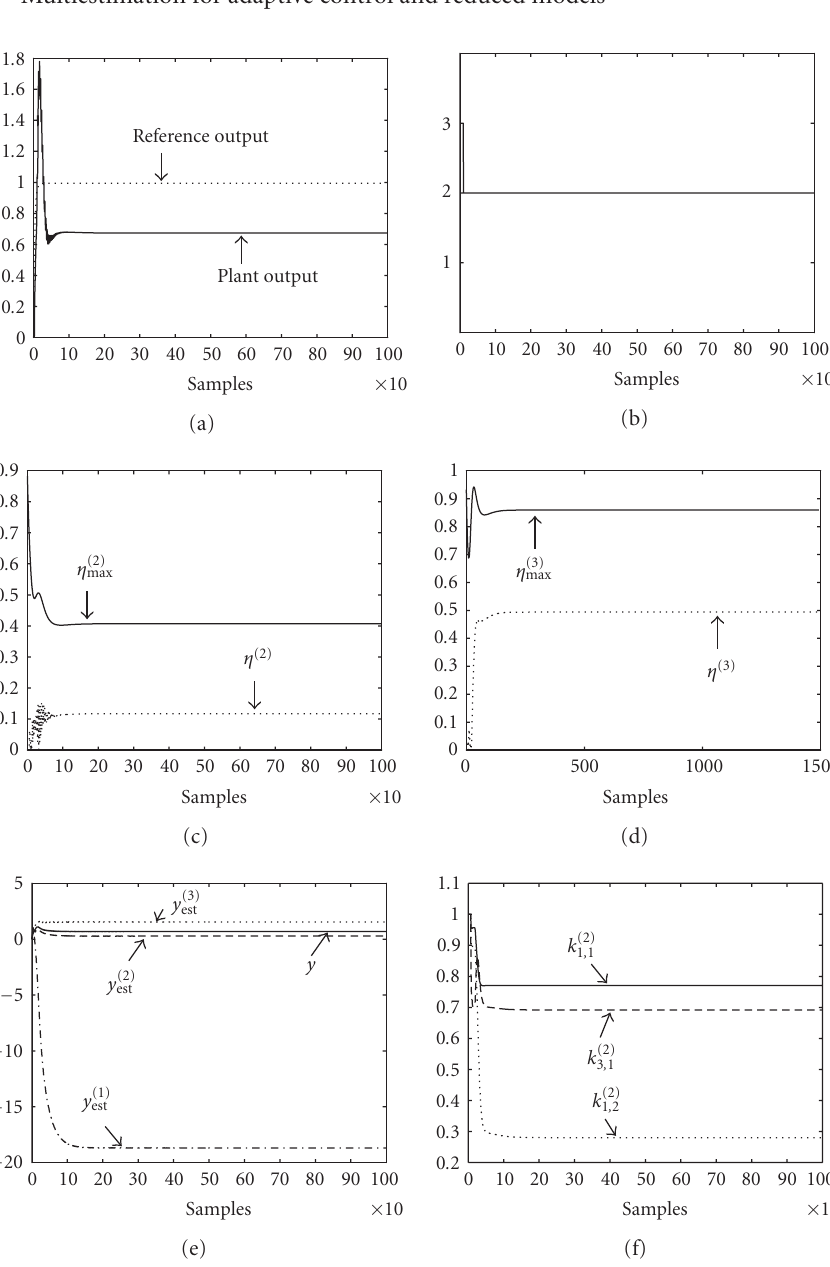
Figure 4.1. (a) Reference and plant outputs when the high-level unsupervised multiestimation scheme is used for a unity step input signal. (b) Active controller. (c) Contribution of the unmod- eled part in the second model and the applied upper bound. (d) Contribution of the unmodeled part in the third model and the applied upper bound. (e) Estimated outputs and plant output. (f) Estimated parameters for the second